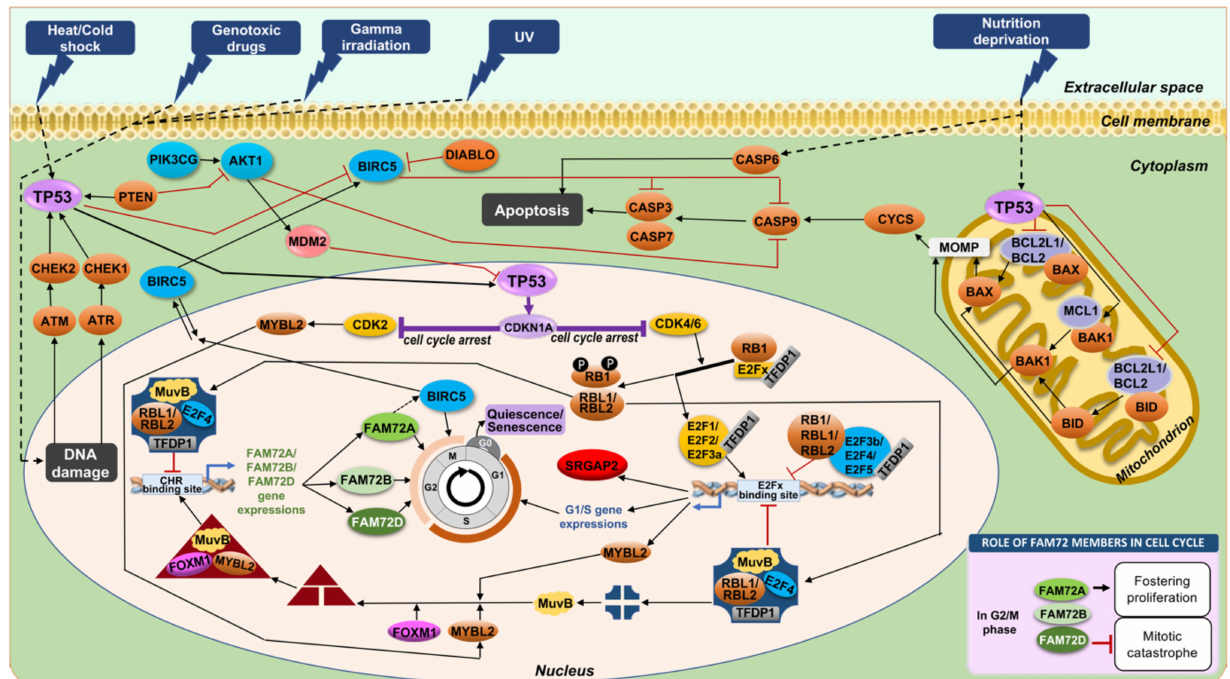
Figure 7. The influence of TP53 on FAM72 paralogs directly regulates the cell cycle in cancer. Upon a stressful DNA- damaging signal (e.g., gamma irradiation), TP53 gets activated to mediate cell arrest in G0 to give the cell quiescence for cell repair or, if impossible, to induce the alternative pathway for apoptosis. TP53-mediated cell cycle arrest is conveyed by CDKN1A (p21) causing inhibition of the cell-cycle promoting the CDK4/6-E2Fx pathway; consequently, the G1/S phase genes remain blocked. The TP53-CDKN1A-CDK4/6 pathway also causes activation of DREAM, which in turn blocks FAM72 expression via the CHR element within the IGR of the |-SRGAP2–FAM72-| master